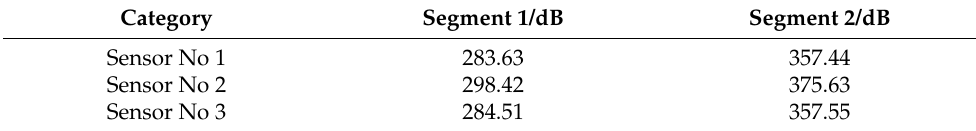
Table 6. Values of vibration level of the two segments in the current stage of